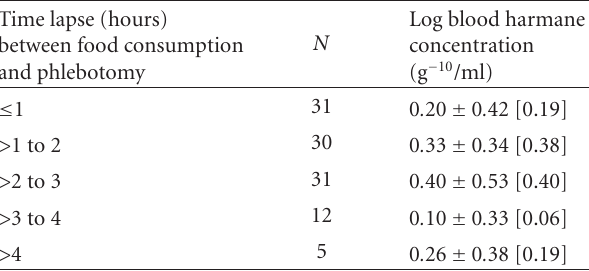
Table 3: Log blood harmane concentrations by categories of time lapse (hours) between food consumption and phlebotomy.